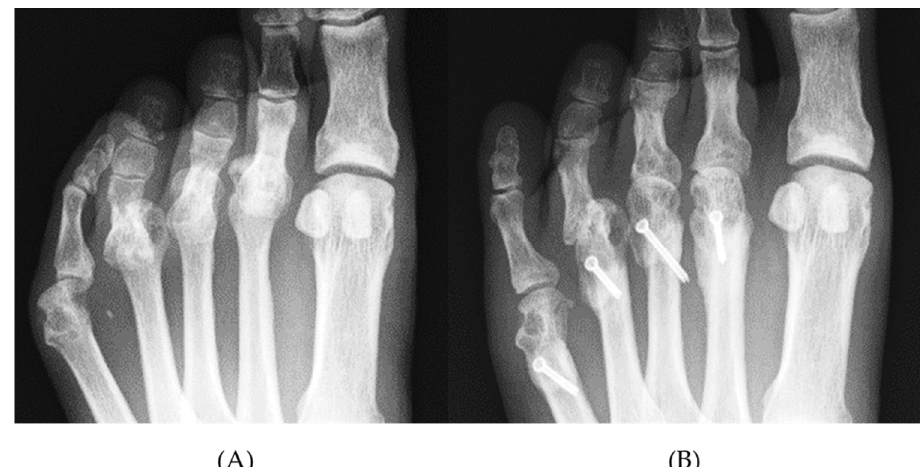
Figure 8. Radiographic findings before ( A ) and after ( B ) shortening oblique osteotomy for lesser metatarsal bones. The preoperative MOD of each toe was 15.9 mm (grade 3), 18.9 mm (grade 3), 17.4 mm (grade 3), and 5.5 mm (grade 2) in the 2nd–5th toes, respectively. Postoperative MOD grades were ameliorated to grade 1 in the 2nd, 3rd, 5th MTP joint. In the 4th MTP joint, postoperative MOD was 10.9 mm (grade 3), and there was a recurrent dorsal dislocation, causing the remnant callosity on the plantar side. The ratio of metatarsal shortening/preoperative MOD (%) was 30%.